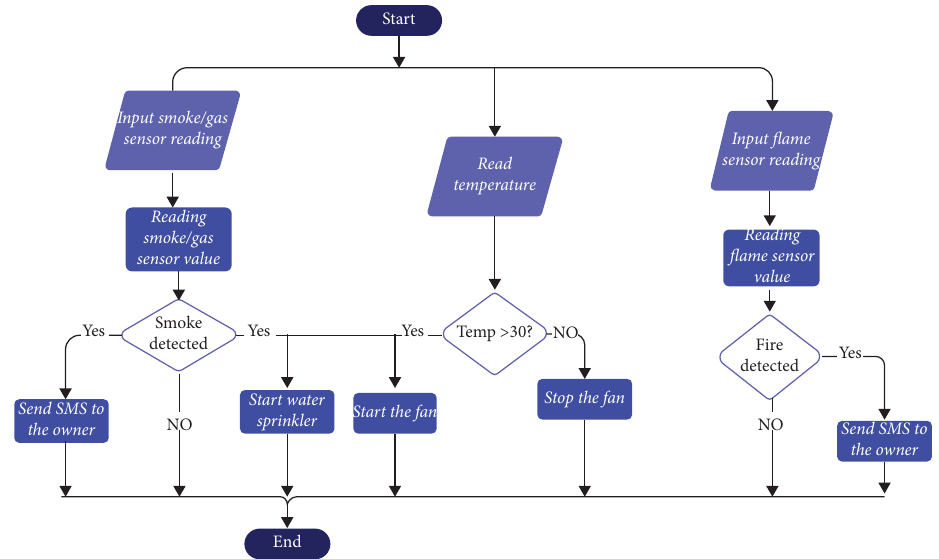
Figure 4: Te fowchart of fammable gases, smoke, and fre detecting and